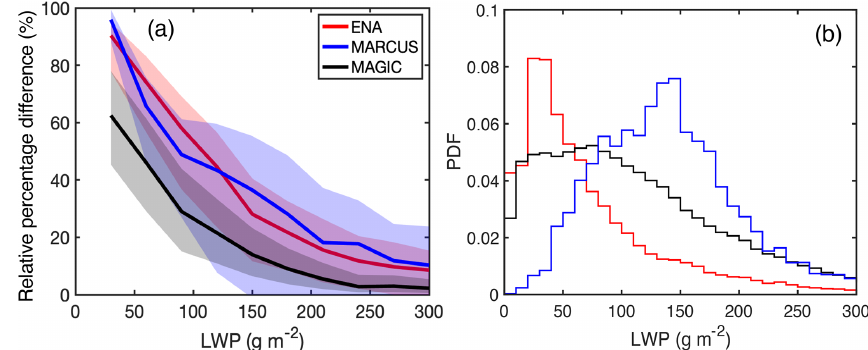
Figure 7. (a) Relative percentage difference in drizzle detection between the dBZA (dBZ > − 17) and MLA as a function of LWP in ARM observational campaigns: ENA (red line), MARCUS (blue line) and MAGIC (black line). The shaded area indicates the same results but with a different reflectivity threshold: the upper boundary is for dBZ > − 15 and the lower boundary is for dBZ > − 20. (b) Histograms of the LWP distribution collected in three campaigns: ENA (red line), MARCUS (blue line) and MAGIC (black